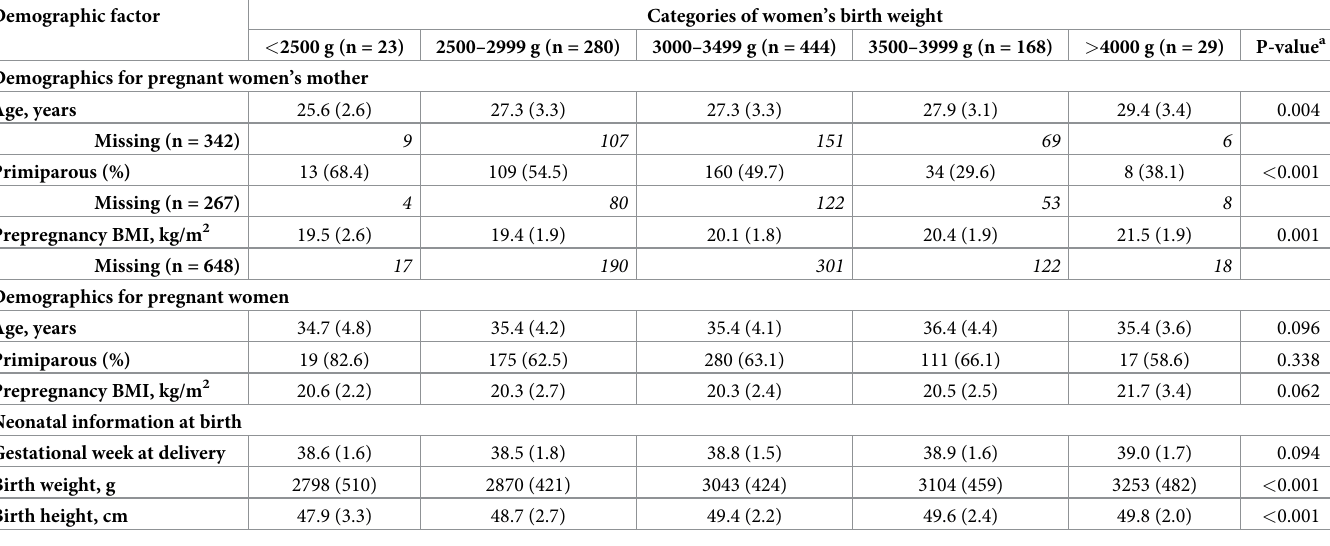
Table 1. Characteristics of pregnant women’s mothers and pregnant women (N = 944) by categories of women’s birth weight.